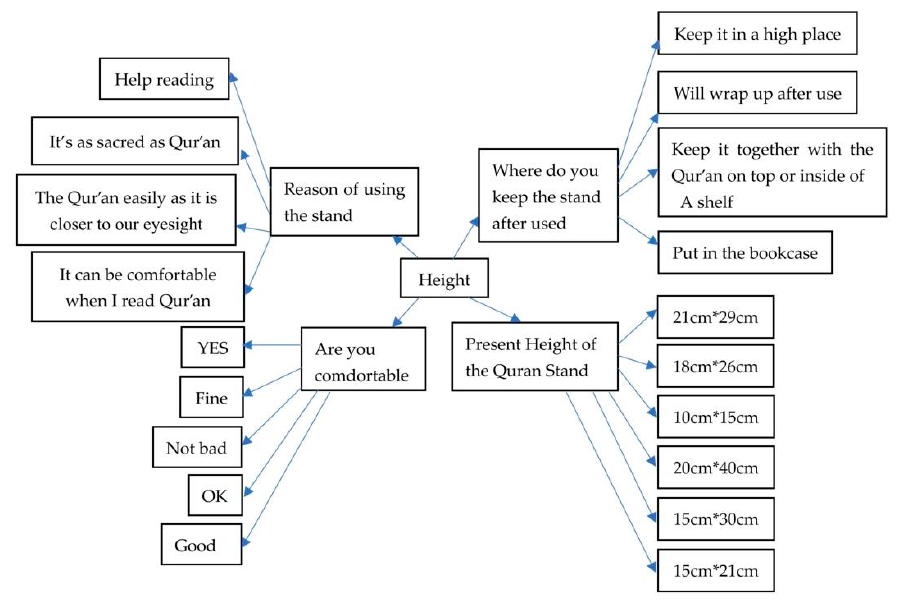
Figure 5. Atlas-ti network view of the height of the rehal. Table 3. Analysis of interview content of Question 2.